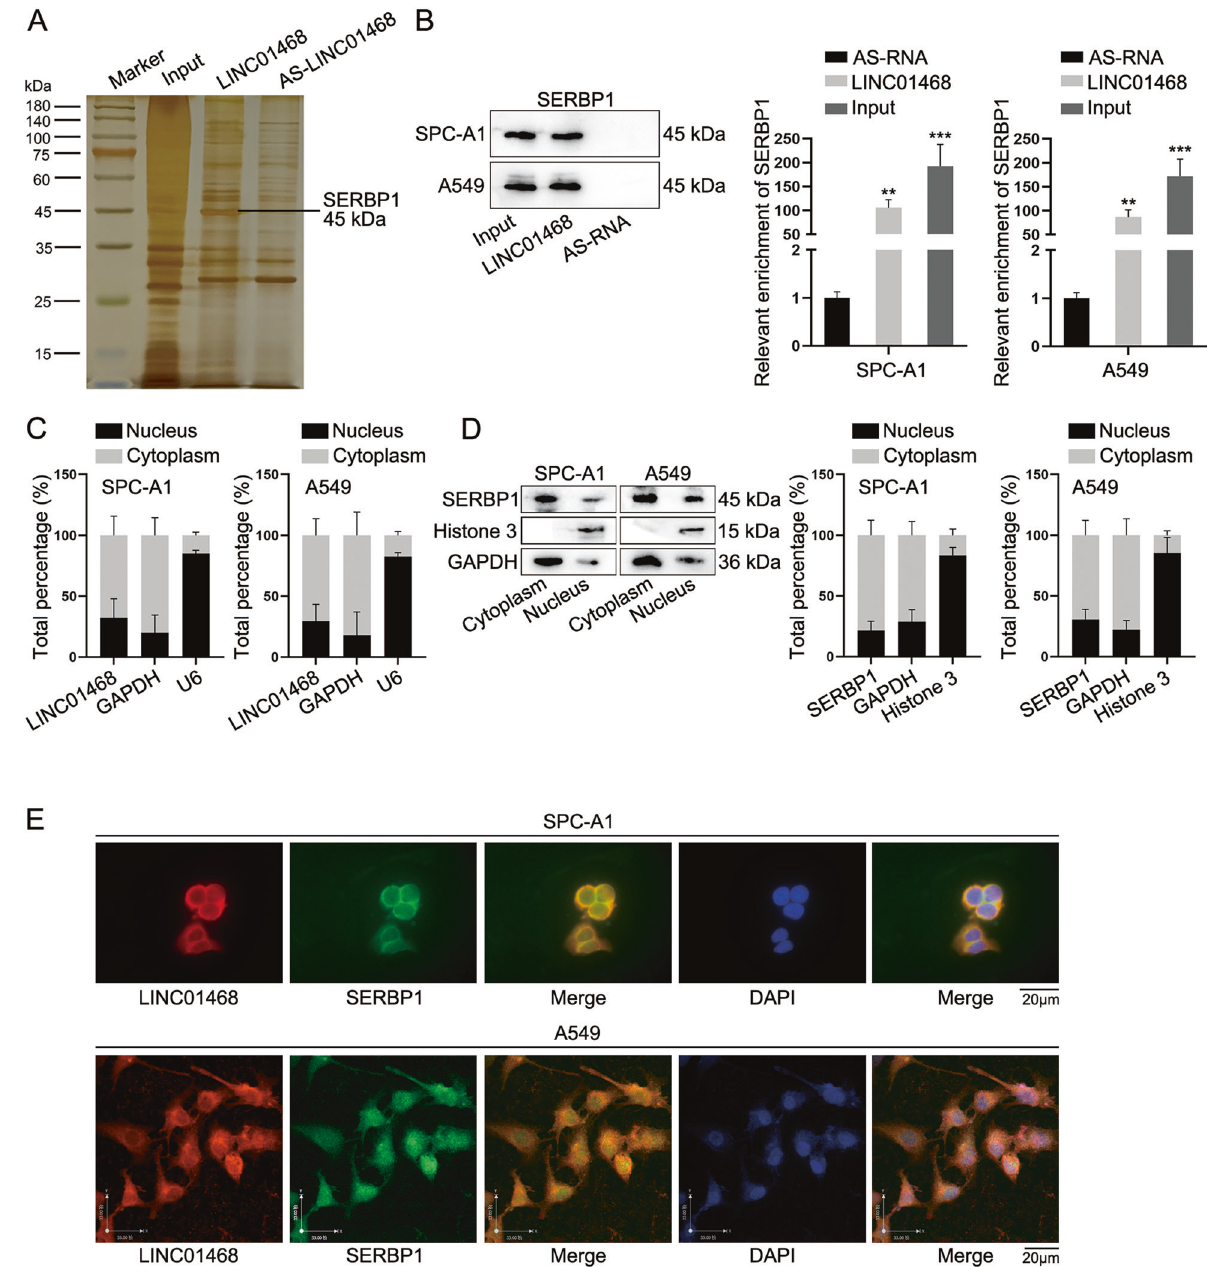
Fig. 4 LINC01468 binds with SERBP1 in cytoplasm. A RNA pull-down assay with mass-spectrometry was performed to obtain LINC01468- binding proteins. B After RNA pull-down assay, western blot analysis was done for measurement of SERBP1 level pulled down by indicated probes. C , D After subcellular fractionation, RT-qPCR and western blot analyses were, respectively, done to examine the accumulation of LINC01468 and SERBP1 in cytoplasm and nucleus of LUAD cell lines. E FISH-IF was applied to determine the co-localization of LINC01468 and SERBP1 in LUAD cells. Results were exhibited as the mean ± SD on the basis of three independent experiments. ** p < 0.01, *** p < 0.001 indicated the statistical signi fi cance of experiments